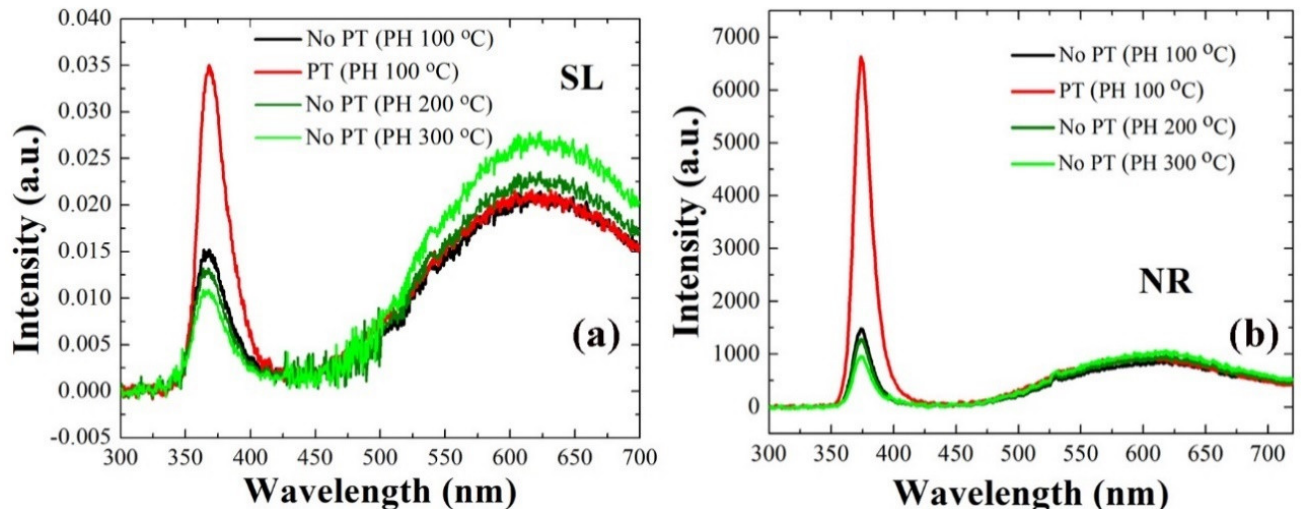
Figure 4. Room-temperature PL spectra of ZnO SLs ( a ) and NRs grown on the SLs ( b ) prepared under different conditions.